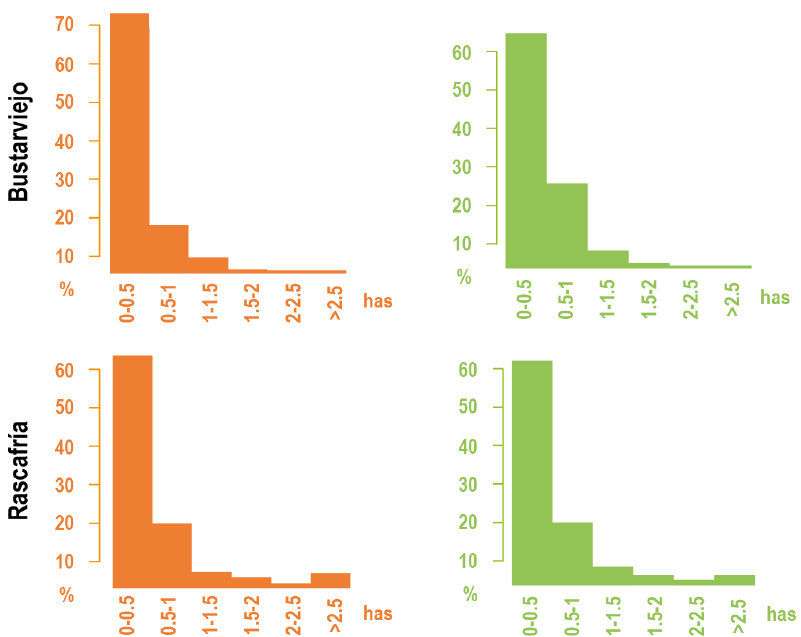
Figure 8. Relative surface area (ha) of enclosed fields in each municipality (1956–2019). Own elabo- ration.